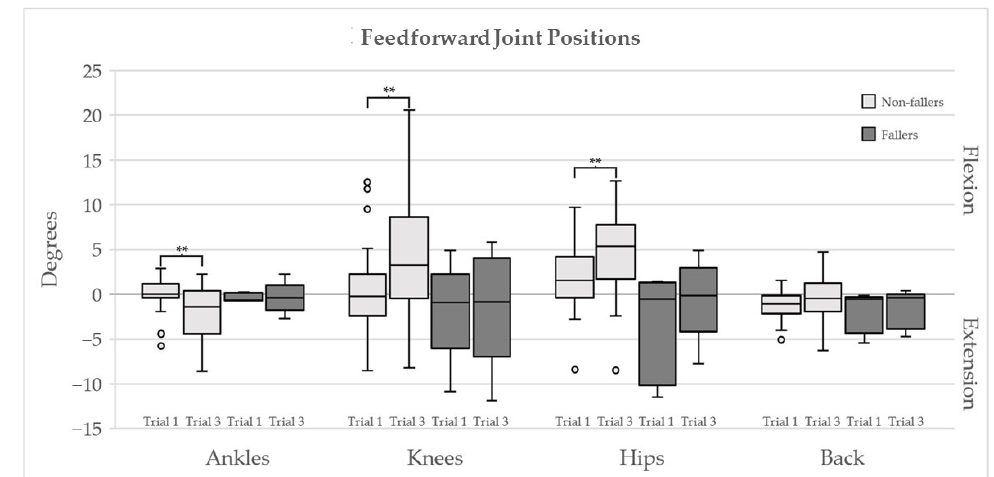
Figure 2. Boxplots of the feedforward joint positions prior the first and the third perturbation trials for the non-fallers (light grey) and fallers (dark grey). The positive values indicate knee, hip, and back flexion as well as ankle plantar flexion. Difference between the two trials for the respective groups were tested with the Wilcoxon signed rank test; double asterisks indicate significant difference p < 0.001. Table 2. Range of motion for each joint during the feedback period for the first and third trial are presented in median and interquartile range for the respective group. Maximum Joint Angle